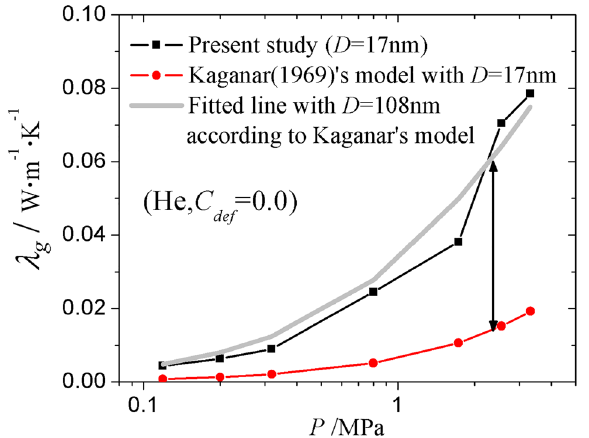
Figure 7. The measured (cid:31) g of aerogels with pore size of D = 17 nm from the molecular dynamics simulation, as well as the predicted (cid:31) g based on Kaganar’s model with pore size D = 17 nm and the fitted characteristic size D = 108 nm as a function of the gas